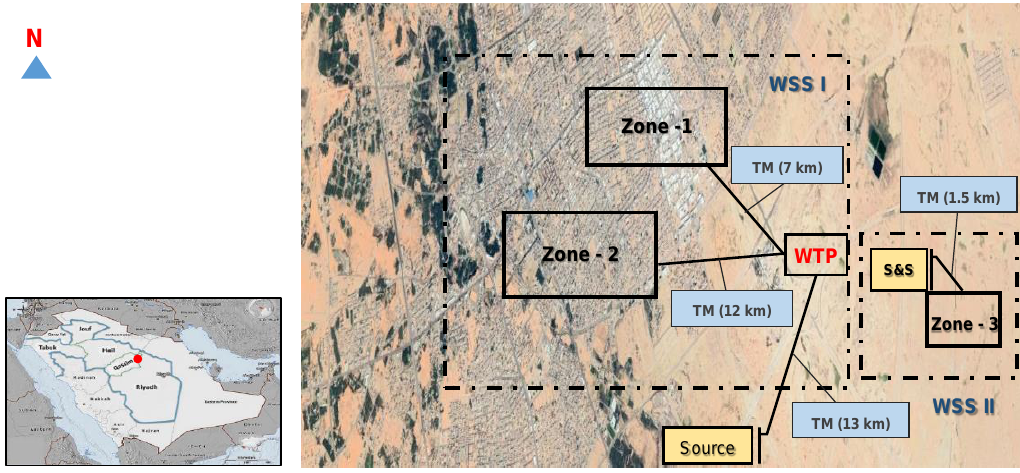
Figure 2. Location of study area. Red dot on the left figure showing the location of study area in Qassim Province, KSA.